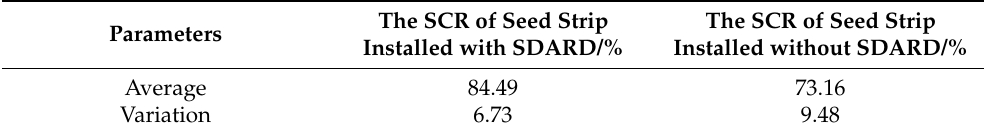
Table 6. Field test results of straw cleaning effect of sowing